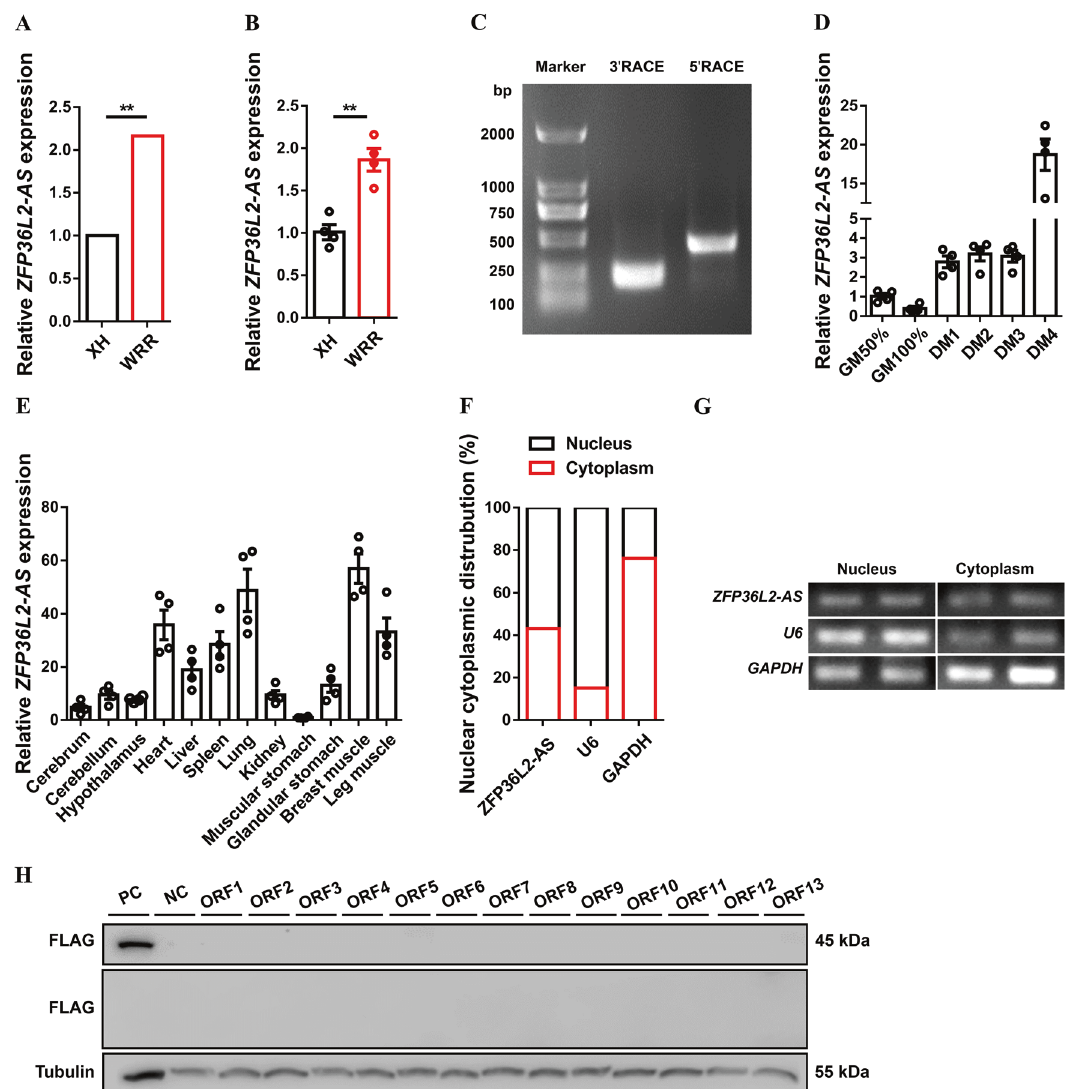
Fig. 1 Identi fi cation of lncRNA ZFP36L2-AS . A , B Relative ZFP36L2-AS expression in breast muscles of 7-week-old Xinghua (XH) chicken and White recessive rock (WRR) detected by RNA-seq ( A ) and qPCR ( B ). ( C ) Results of ZFP36L2-AS 3 ’ RACE and 5 ’ RACE. D Relative ZFP36L2-AS expression during CPM proliferation and differentiation. E Tissue expression pro fi les of ZFP36L2-AS . The horizontal axis and vertical axis indicate different tissues and their relative expression values, respectively. F , G The distribution of ZFP36L2-AS in the cytoplasm and nuclei of chicken primary myoblast (CPM) was determined by qPCR ( F ) and semi-qPCR ( G ). GAPDH and U6 serve as cytoplasmic and nuclear localization controls, respectively. H Western blot analysis of the coding ability of ZFP36L2-AS . The potential ORFs of ZFP36L2-AS were cloned into the pcDNA3.1-3xFlag-C vector. CPMs transfected with β -actin were used as a positive control (PC) and untransfected CPMs were used as a negative control (NC). Results are presented as mean ± SEM. In panels ( A , B ), statistical signi fi cance of differences between means was assessed using independent sample t -test. (* P < 0.05; ** P <